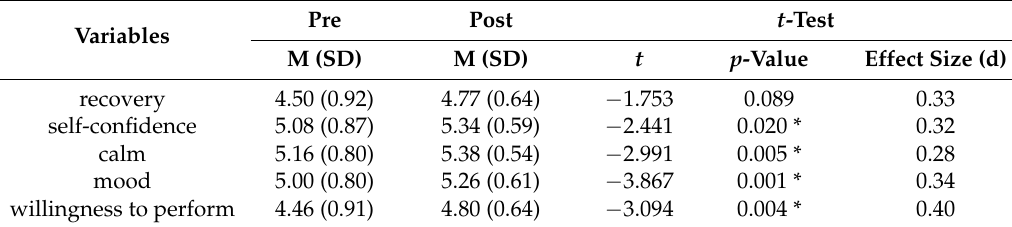
Table 4. Results of the paired t -test for pre- and post-measurements of each dimension of the